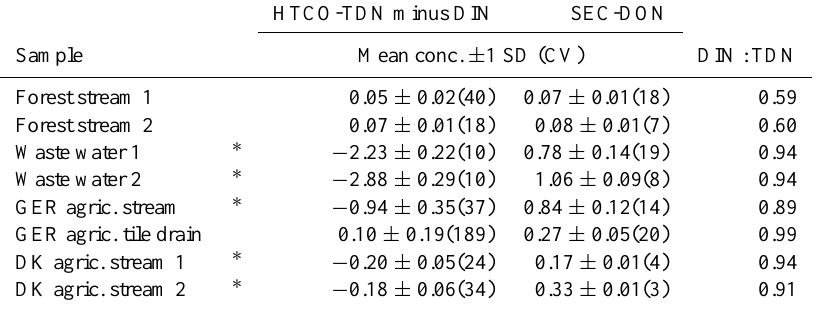
Table 4. DON concentrations of natural samples determined by the standard approach as HTCO-TDN minus DIN or directly by SEC as SEC-DON. Please see Table 1 for further details on the samples. Mean concentrations (mgNL − 1 ), standard deviations and coefficients of variation (CV) are given. CVs are given as percentages (CV=standard deviation · 100/mean). ∗ indicates significant differences between the results of the two measurement methods according to the bootstrap test (see Appendix A for details on the test). DIN:TDN ratio was calculated as DIN:TDN ratio=((NO − +NO − )+NH + )/(SEC-DON+(NO − +NO − )+NH + 3 2 4 3 2 4